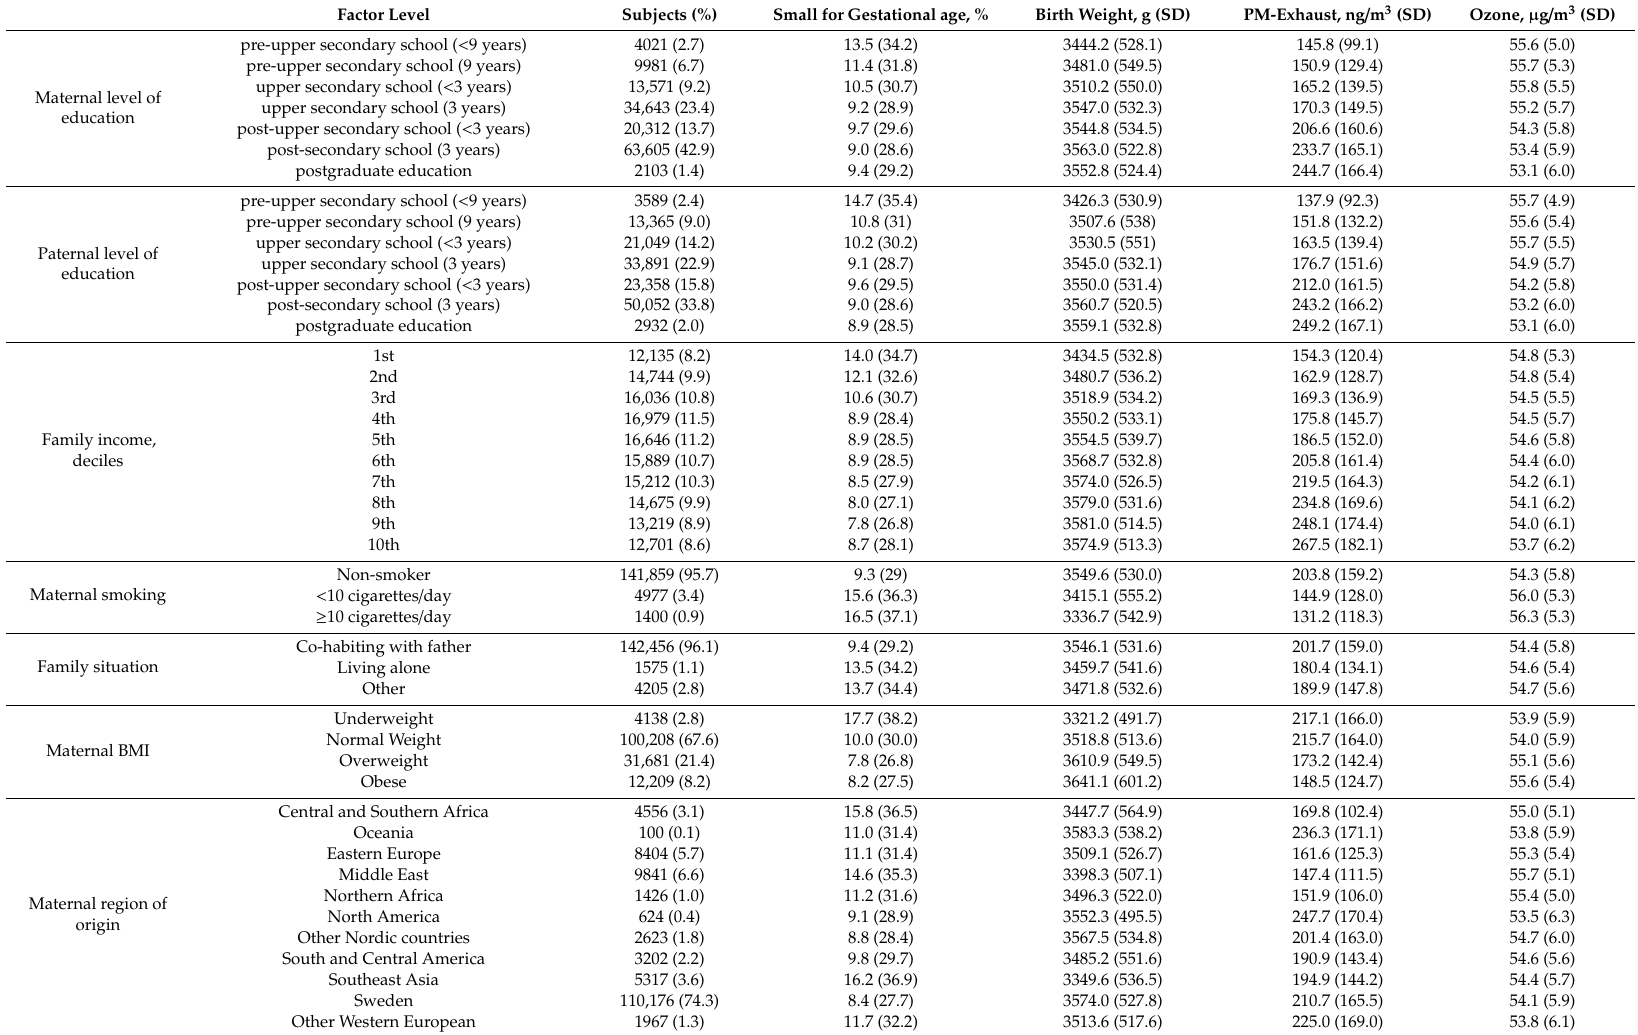
Table 2. Summary table of outcomes and exposure levels during full pregnancy in di ff erent sub-groups of the study population. Factor